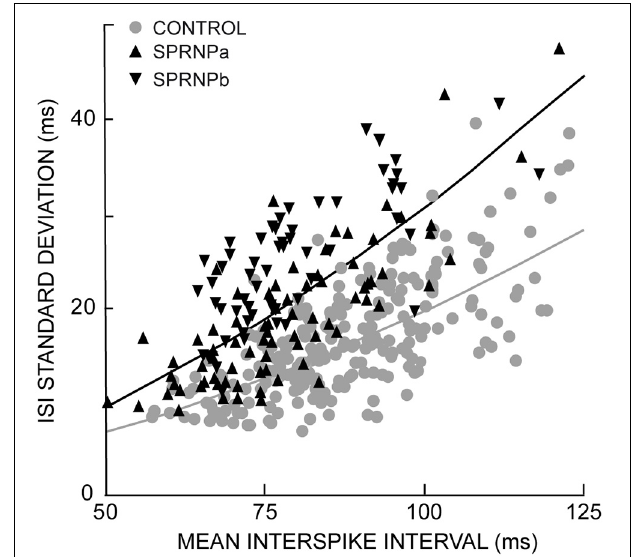
FIGURE 2 | Exponential relationship between each MU standard deviation and mean ISIs; healthy subjects gray curve and dots; SPRNP patient black curve and triangles (tip up and down, set a and b, respectively).